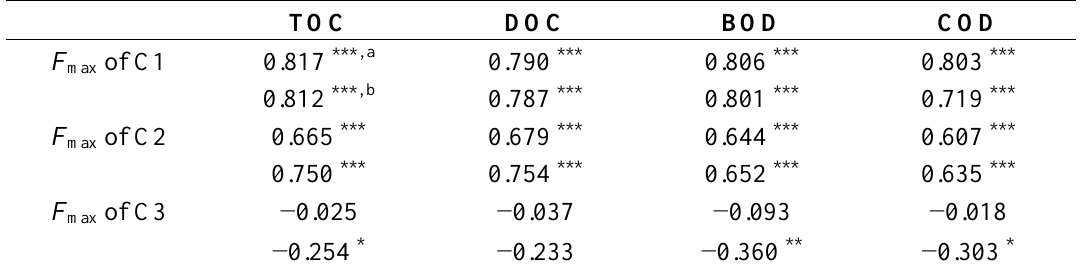
Table 2. Correlation coefficients (Pearson r values and Spearman  values) between conventional organic matter concentration indices and fluorescence intensities of three PARAFAC components (n = 71).